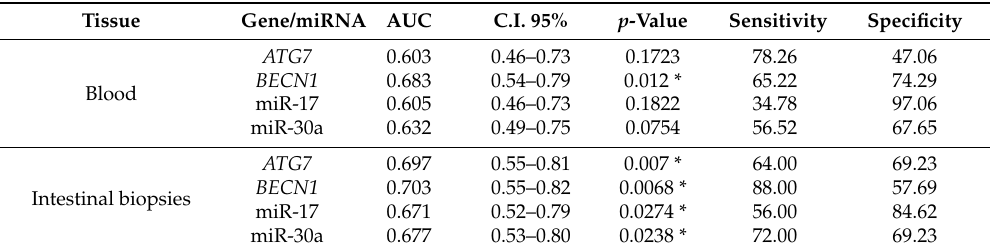
Table 2. ROC curve analysis of the association of autophagy-related genes and miRNAs relative expression with CD status.